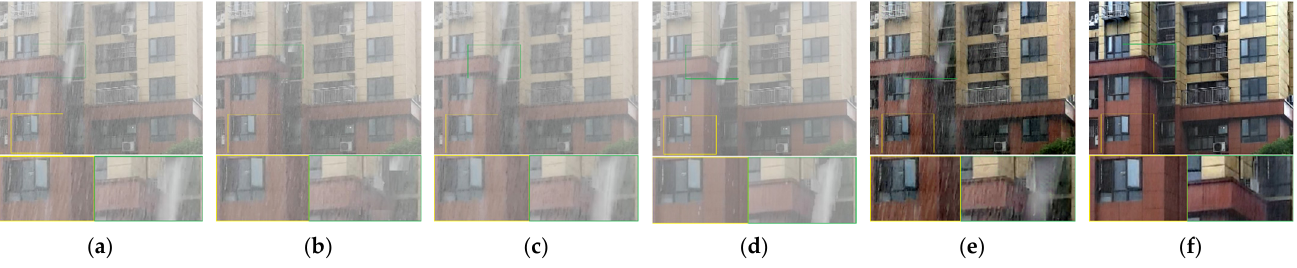
Figure 7. Comparison on a real rain video. ( a ) Input, ( b ) Kim et al. [16], ( c ) Wang et al. [8], ( d ) Li et al. [14], ( e ) Chen et al. [32], ( f ) proposed method.